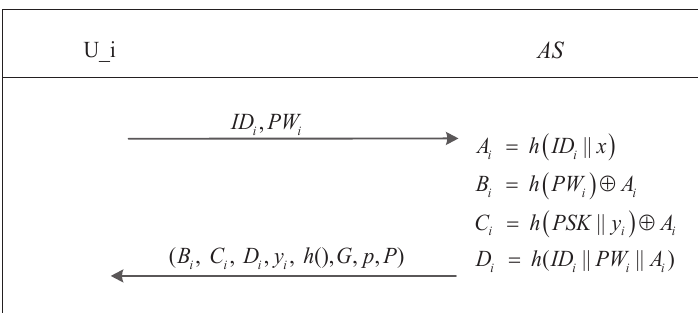
Figure 3. Normal vehicle registration